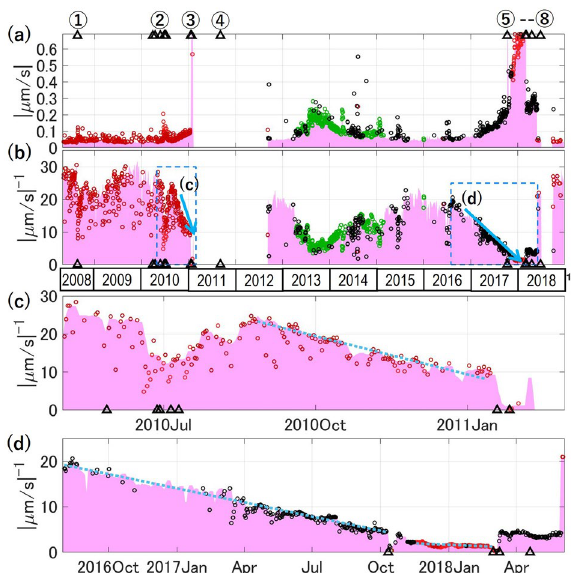
Figure 6. Application of FFM to SBL. ( a ) The daily SBL at SMN belonging to the clusters related to volcanic activity (Gn, Rn1, Rn2, and Kn). The colors are the same as in Fig. 5a. The light-magenta area shows the weekly smoothed SBL at SMN as in Fig. 2c. ( b – d ). The inverse of the data in ( a ), and the magnifications of the rectangles, ( c ) and ( d ). They exhibit linear slopes down toward the 2011 eruption ( c ) and the 2017 and 2018 eruptions ( d ). The dotted lines show the fitting of the weekly smoothed SBL by Eq. (1) with the parameters listed in Table 1.